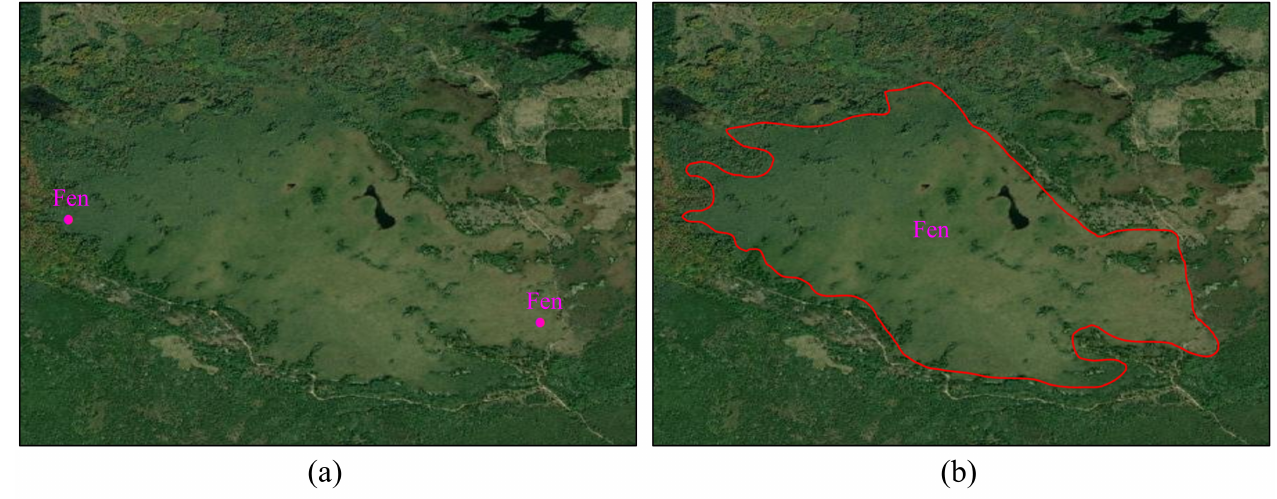
Figure 2. An example of the conversion of ( a ) point-based field samples to ( b ) polygon samples. The red color shows the boundary of a Fen